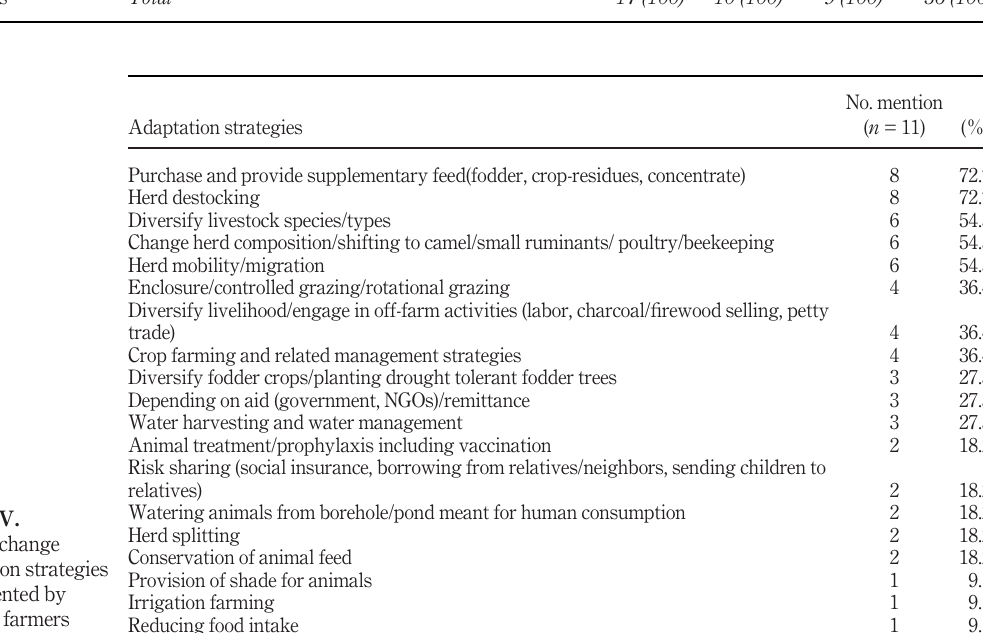
Table III. Regional distribution of studies on determinant factors of CCA in SSA countries